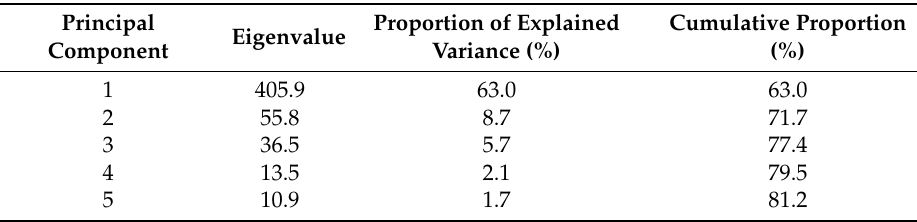
Table 1. Eigenvalues, fractions of explained variance and cumulative proportions of the first five principal components (PCs).